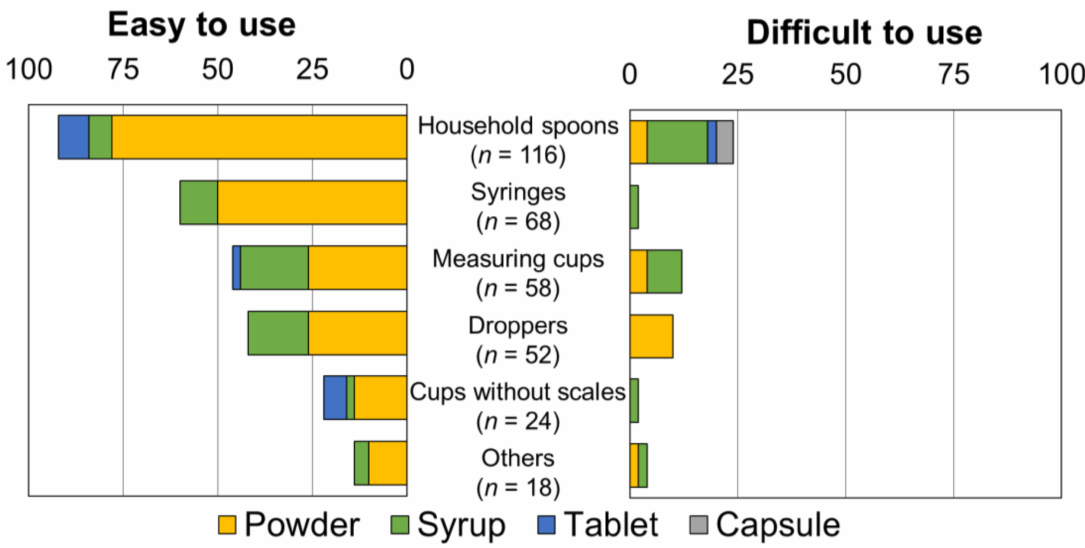
Figure 4. The user-friendliness of used